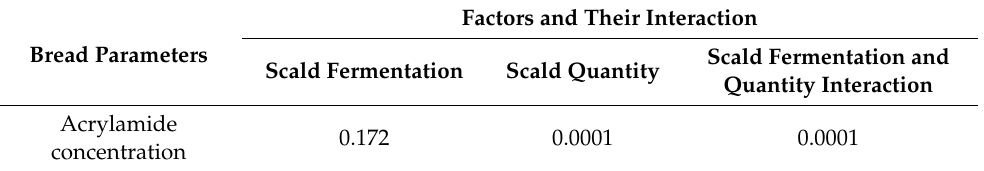
Figure 4. Acrylamide concentration ( µ g/kg) in bread samples (a–c Mean values within columns with different letters are statistically significantly different ( p ≤ 0.05)). Table 8. Influence of analysed factors (fermentation and quantity of the scald, and their interaction) on acrylamide concentration in